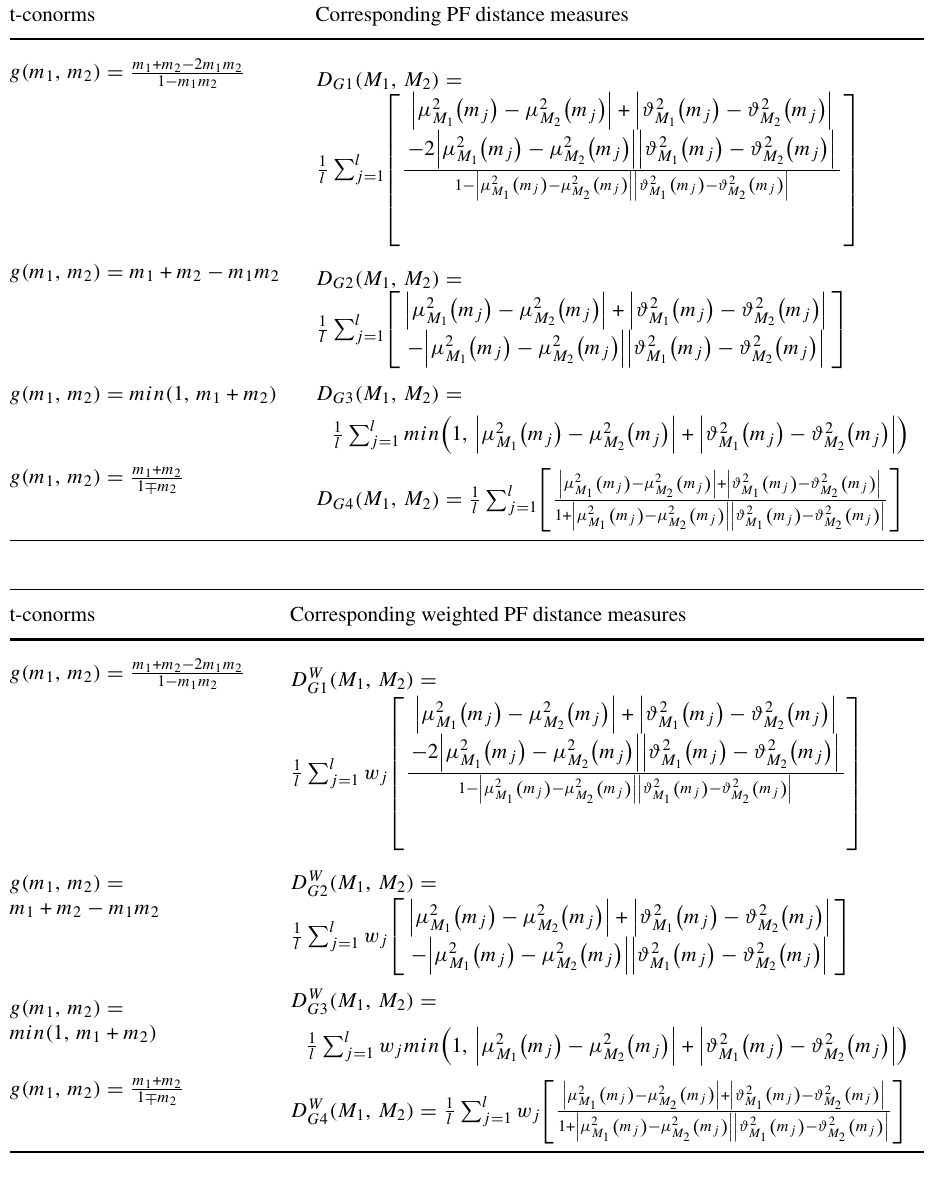
t-conorms Corresponding PF distance measures